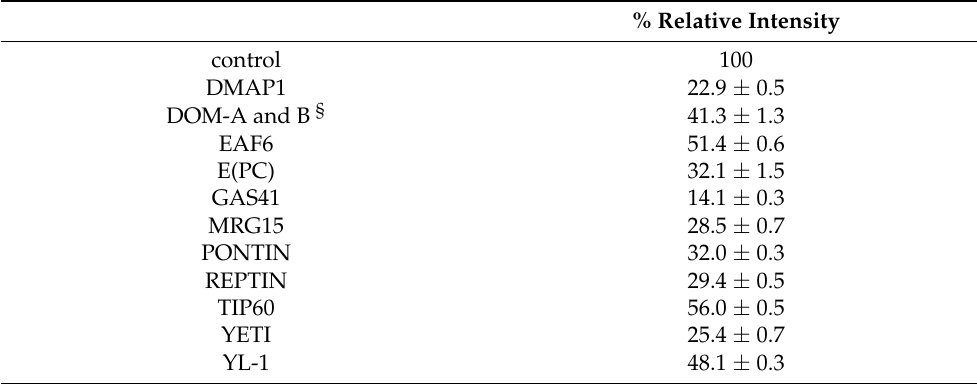
Table 2. sqPCR quantification of silencing of genes coding for the subunits under investigation. The results are expressed as % mean ± SD values from three independent replicate experiments. § Simultaneous silencing.